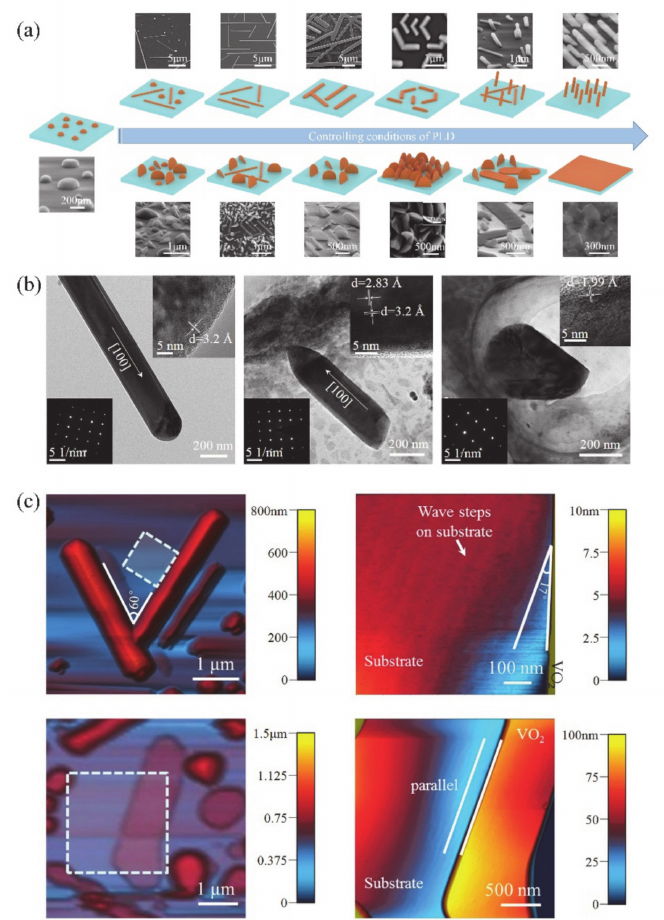
Figure 14. ( a ) Schematic diagrams and corresponding SEM images of as-deposited low-dimensional structures (LDSs). ( b ) TEM images of representative NW, vertically-grown NR and nanoplatelets, and the insets show the corresponding HRTEM images and SAED patterns. ( c ) AFM and high-resolution AFM images of NWs and laterally grown NPs. Reproduced from [16], with permission from Royal Society of Chemistry,